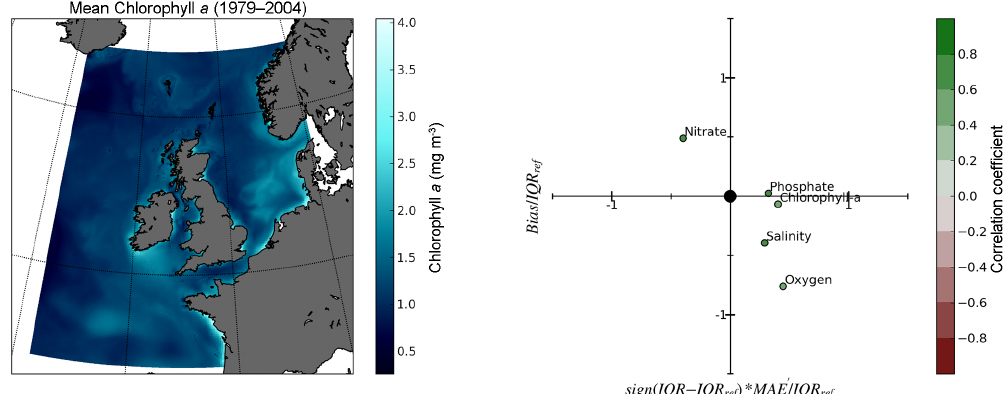
Figure 11. The ERSEM model in a simulation for the north-western European shelf seas – left panel: optical-depth-averaged chlorophyll a ; right panel: hindcast simulation vs. in situ data.